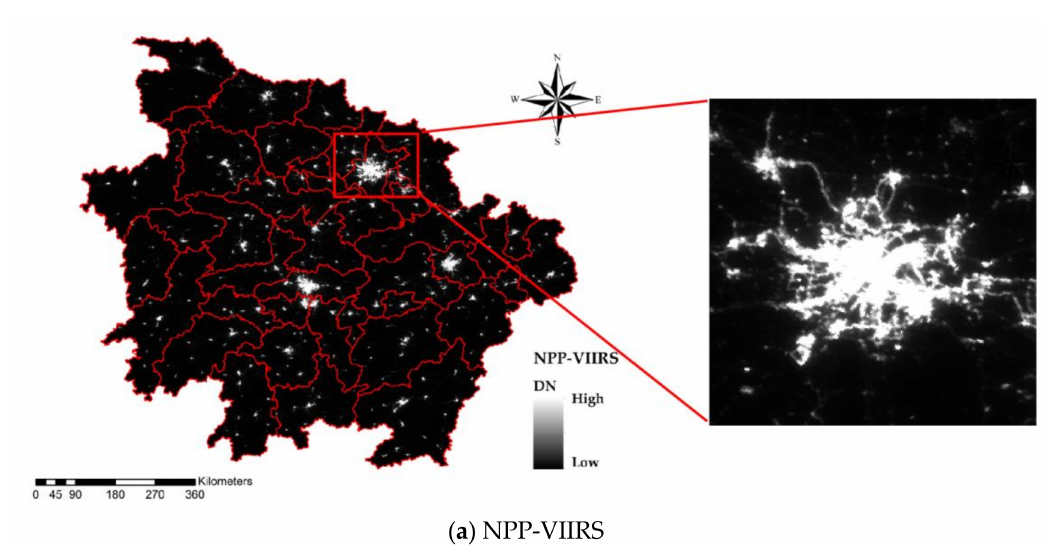
Figure 2. The NPP-VIIRS NTL data processing flow.